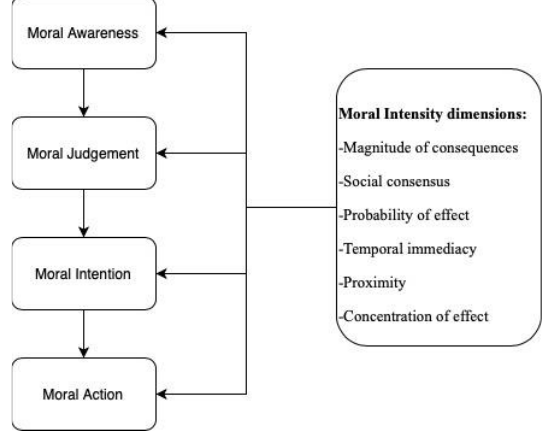
Figure 1: Ethical decision-making process and moral intensity dimensions; Source: Rest 1986; Jones